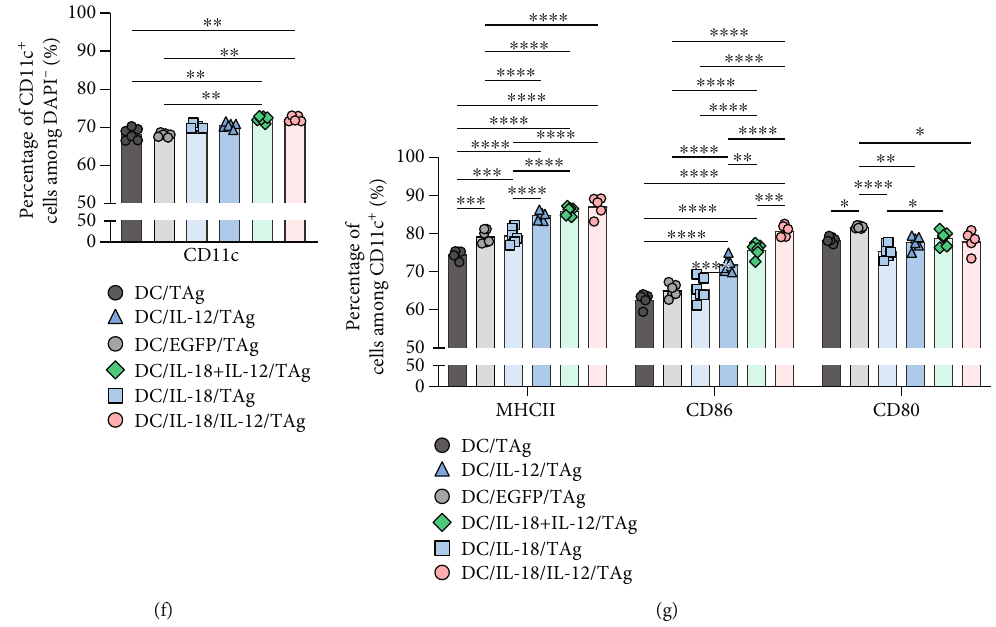
Figure 1: The in fl uence of lentiviral transduction with il12 and il18 genes on bone marrow-derived dendritic cells (DCs). (a) Preparation schedule of genetically modi fi ed DCs. (b) Expression of EGFP by DC/TAg cells. Control DC/TAg cells (black histogram) and DC/EGFP/ TAg (green histogram). (c) Concentration of IL-12 and IL-18 in supernatants collected on the 9th day of DC culture measured using ELISA. (d) Relative expression of murine IL-12p35 mRNA and murine IL-18 mRNA in transduced cells on the 9th day of DC culture measured by real-time PCR. (e) Scheme of phenotype analysis of vaccine cells. (f) Percentage of CD11c + cells on the 8th day of DC cultured. (g) Expression of MHC II and costimulatory molecules (CD86 and CD80) on the surface of CD11c + cells, on the 9th day of culture, measured using fl ow cytometry. Results are presented as mean + SD calculated for at least three repeats in two independent experiments. Di ff erences between groups were estimated using the nonparametric Kruskal-Wallis test followed by Dunn ’ s multiple comparison post hoc test ((c) concentration of IL-12; (d, f)) or one-way ANOVA followed by Tukey ’ s multiple comparison post hoc